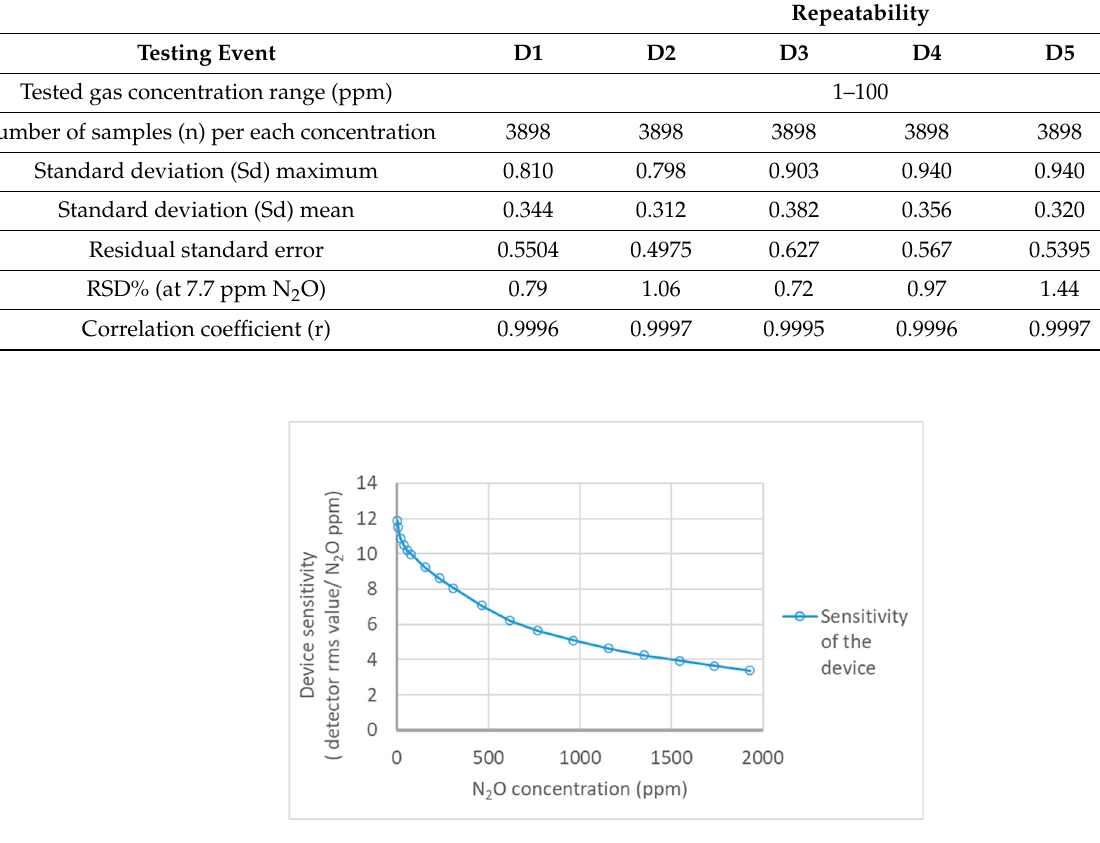
Figure 6. Sensitivity of the device at each N 2 O gas concentration levels. Table 1. Results of the repeatability test of the new device.